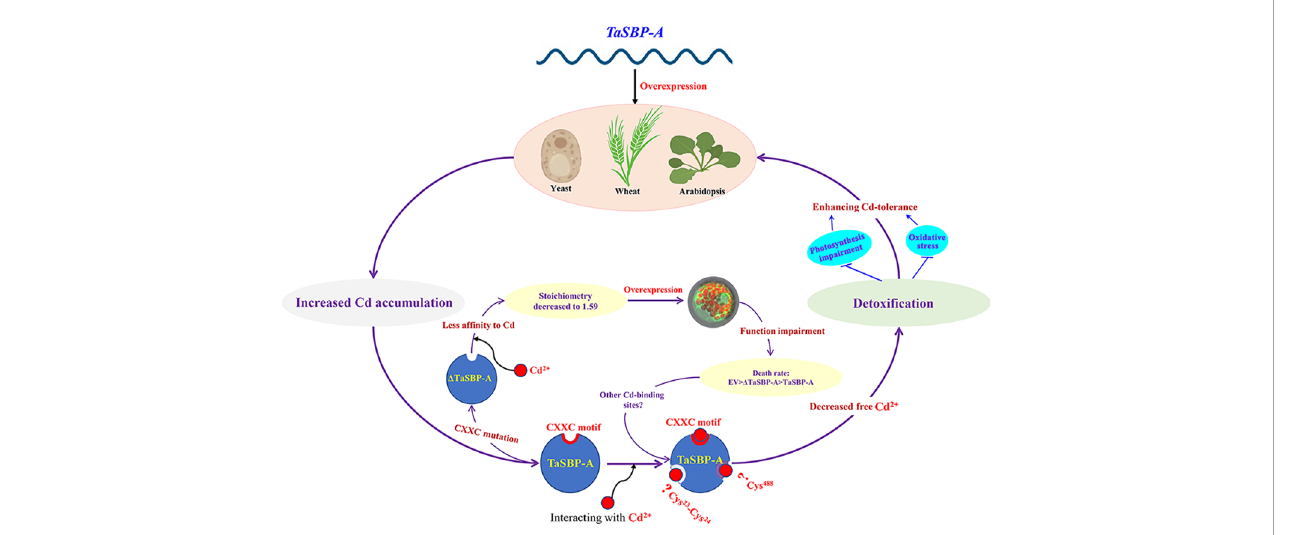
FIGURE 7 Schematic representation of TaSBP-A involved in Cd 2+ -binding and detoxi fi cation in plants. The overexpression of TaSBP-A confers Cd-tolerance in yeast, Arabidopsis and wheat through the detoxi fi cation of free Cd 2+ . The interaction between the CXXC motif and Cd enhances the sequestration of free Cd 2+ , inhibits the Cd transfer from root to leaf and reduces the content of Cd 2+ in plant leaf, ultimately conferring plant Cd-tolerance via alleviating the oxidative stress and photosynthesis impairment triggered by Cd